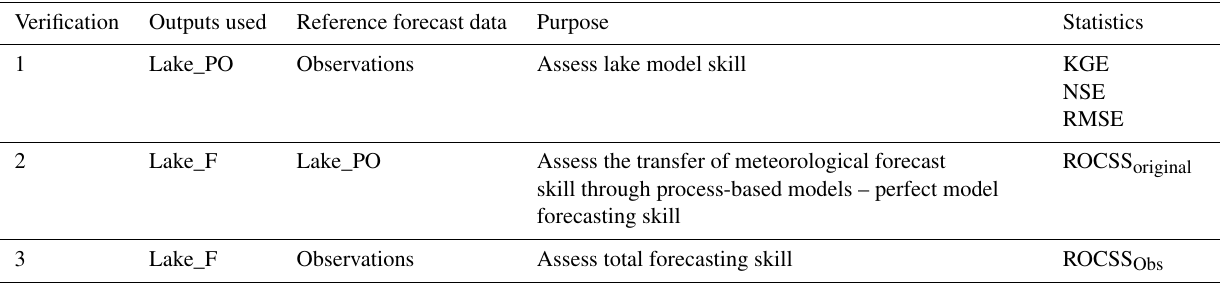
Table 2. Comparison carried out to evaluate model and forecast